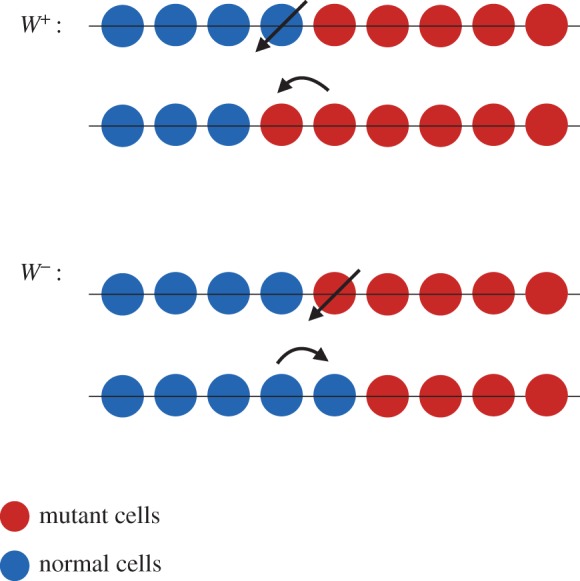
Sequence of events in a DB process on a line (circle). The transition probabilities W± are indicated by the corresponding events.